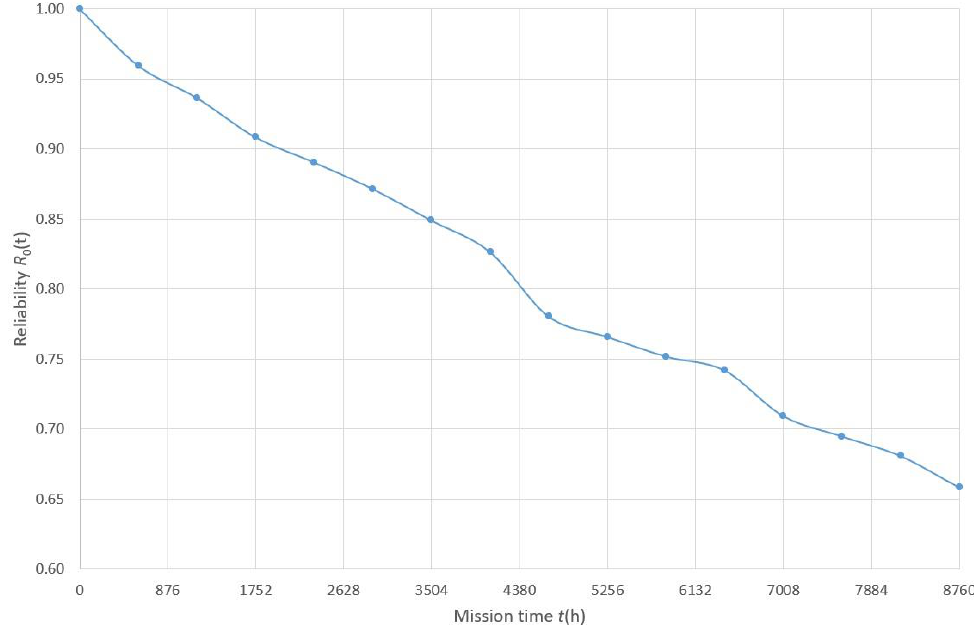
Figure 6. Probability of an explosion in the starting air manifold during the first year of engine operation (to the first failure).